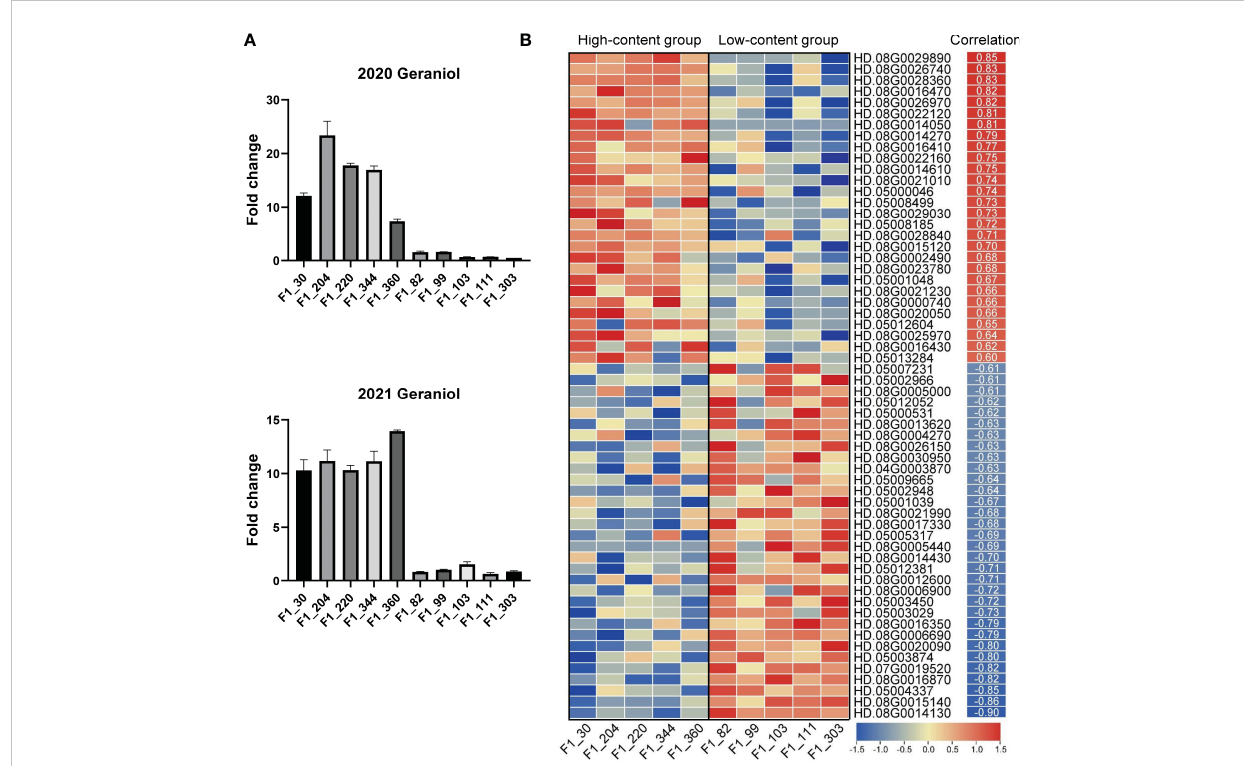
FIGURE 4 RNA-Seq data analysis of candidate genes for volatile terpene contents in tea plant. The contents of geraniol in ten selected F 1 individuals in 2020 and 2021 (A) . Results are expressed as mean ± SEM ( n = 3). Expression patterns of candidate genes in Chr05 cluster (B) . Pearson ’ s correlations between geraniol contents and the expression levels of candidate genes in 2021 are shown on the right of heatmap.